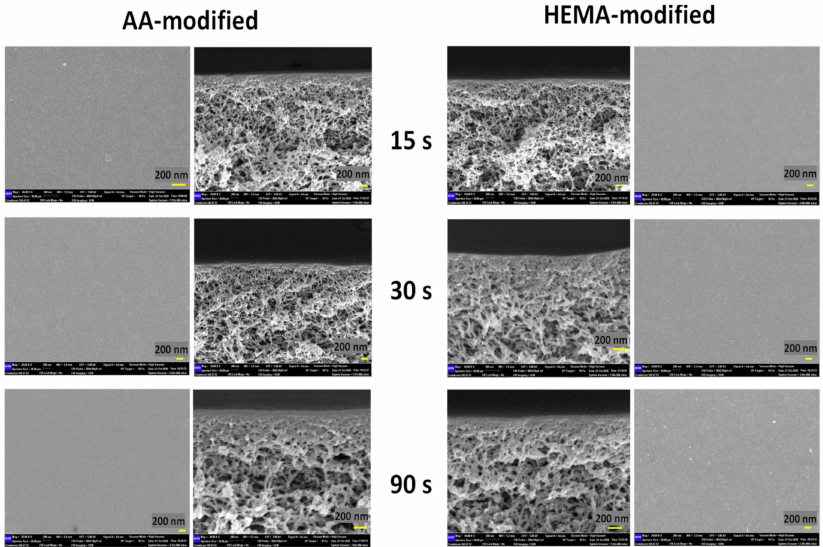
Figure 8. Surfaces and cross-sections of AA-modified and HEMA-modified membranes at various plasma deposition times of 15 s, 30 s, and 90